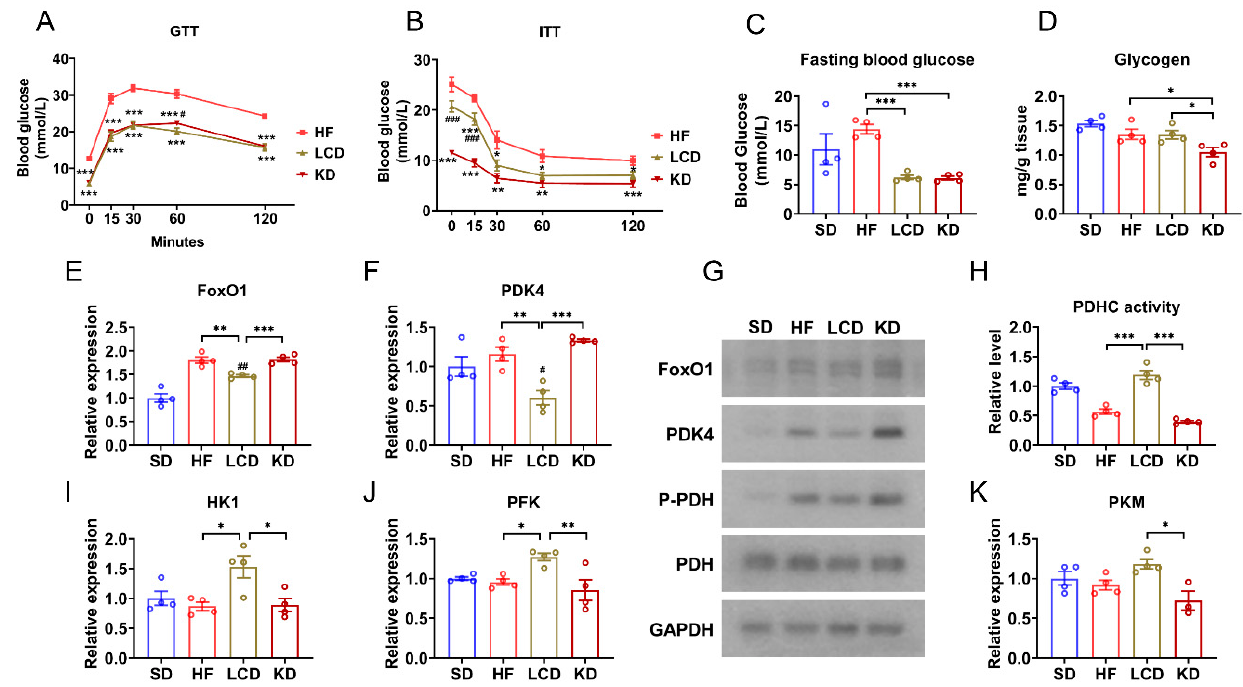
Figure 3. Ketogenic diet inhibited glucose utilization in skeletal muscle. ( A ) GTT of mice with different treatments. ( B ) ITT of mice with di ff erent treatments. ( C ) Fasting blood glucose of mice with di ff erent treatments. ( D ) Glycogen levels in the GAS muscle. ( E , F ) mRNA levels of ( E ) FoxO1 and ( F ) PDK4 in the GAS muscle. ( G ) Western blots of FoxO1, PDK4, and P-PDH in the GAS muscle. ( H ) PDHC activity in the GAS muscle. ( I – K ) mRNA levels of ( I ) HK1 , (J) PFK , and ( K ) PKM in the GAS muscle. Means ± SEM are shown. In Figure 3A,B, * p < 0.05, ** p < 0.01, *** p < 0.001 versus the HF group. # p < 0.05, ### p < 0.01 di ff erences between LCD and KD groups. In Figure 3C–K, # p < 0.05, ## p < 0.01 versus the standard diet group. * p < 0.05, ** p < 0.01, *** p < 0.001 di ff erences between groups.